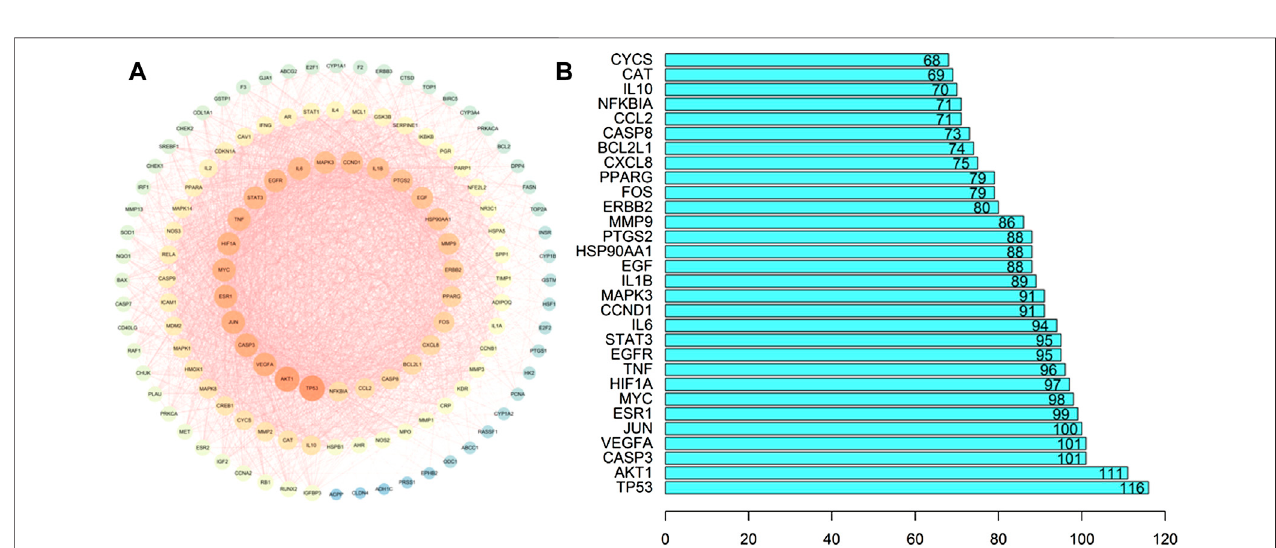
FIGURE 3 | Intersection target PPI network diagram. (A) GO enrichment analysis; (B) core genetic